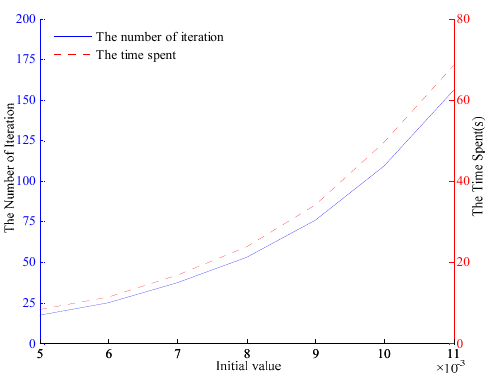
Figure 9. Comparison of computational efficiency.